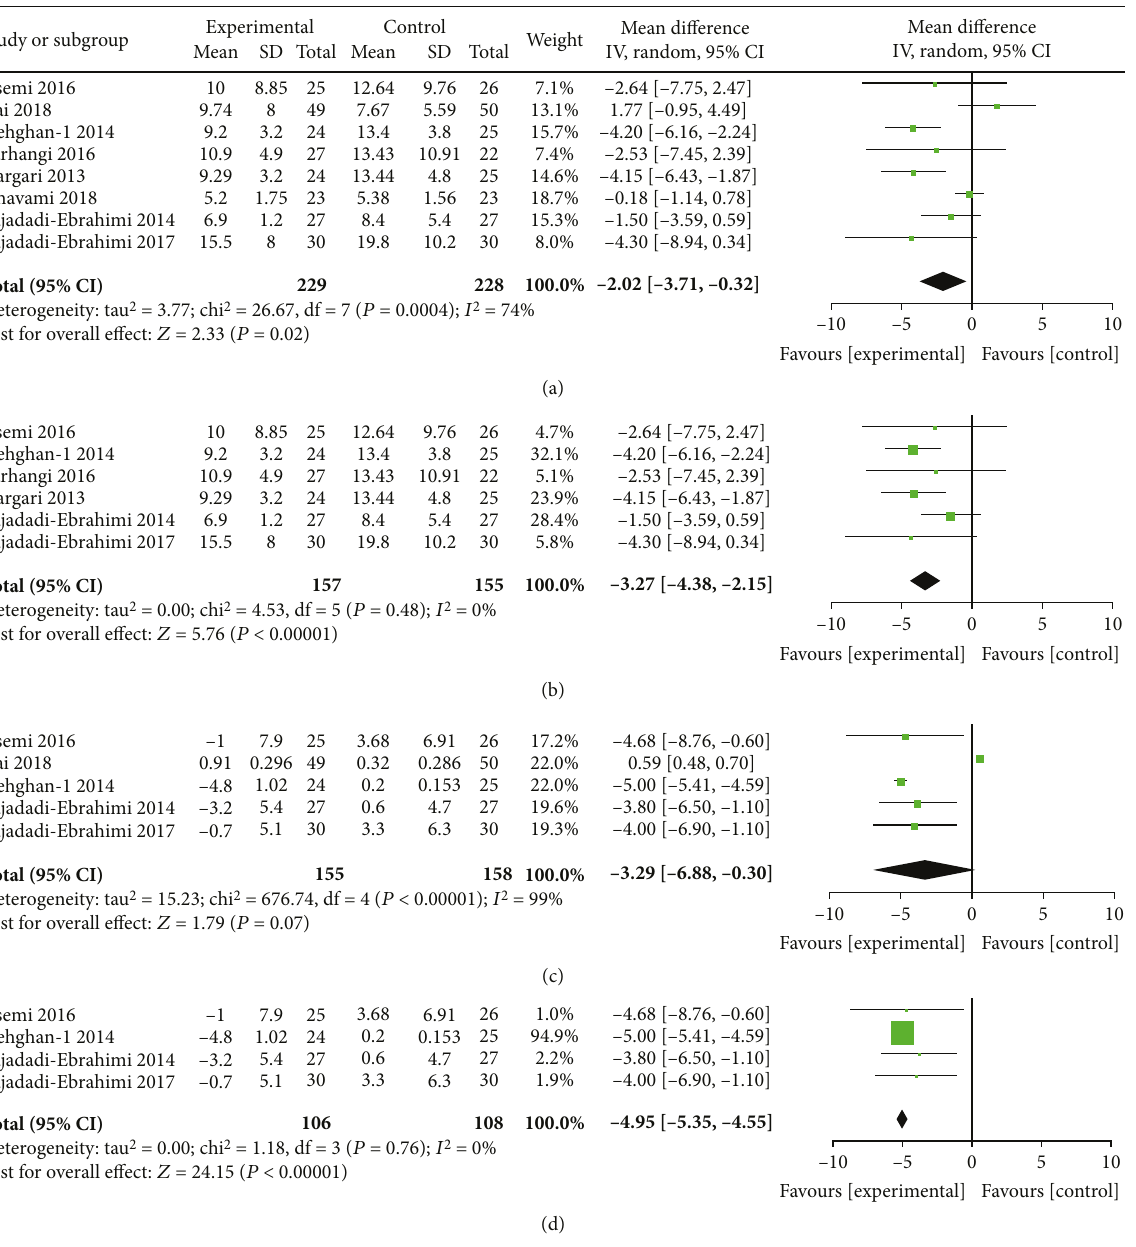
Figure 5: Findings of a meta-analysis of studies with continuation data on improvement in FI for ITC vs. control groups, with estimated MD and 95% CI. (a) Postintervention data of FI, (c) reduction data of FI, and (b, d) subgroup analysis according to the baseline BMI